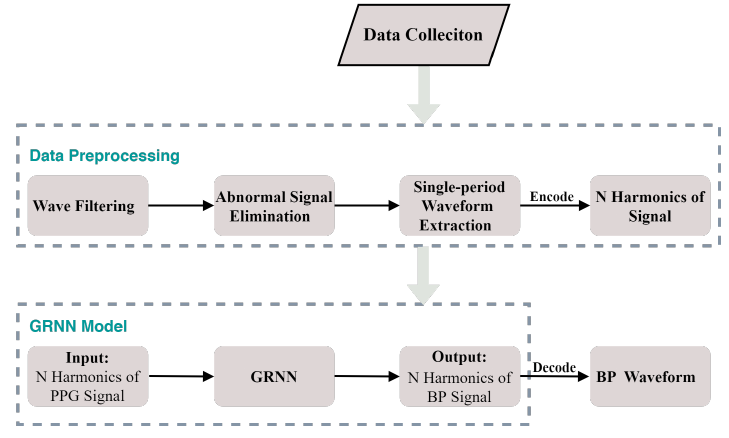
Figure 6. The block diagram of our proposed